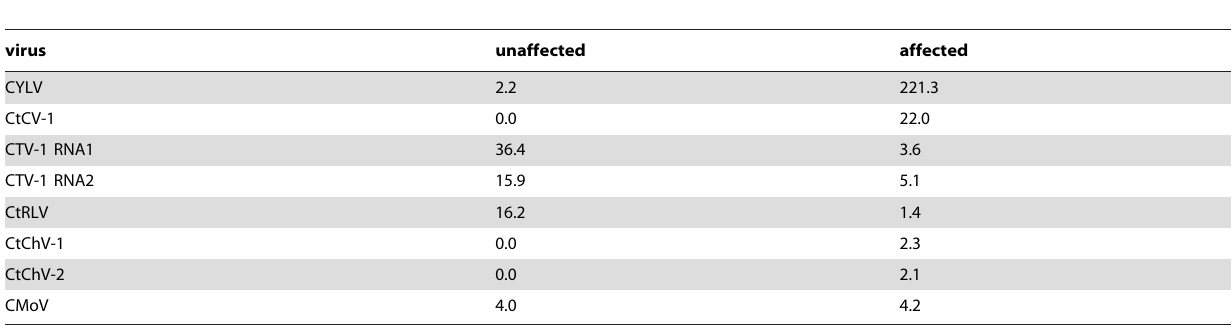
Table 1. Relative abundance (Reads per kilobase of viral genome per million sequenced reads-RPKM) of select viruses in sequenced affected and unaffected samples.